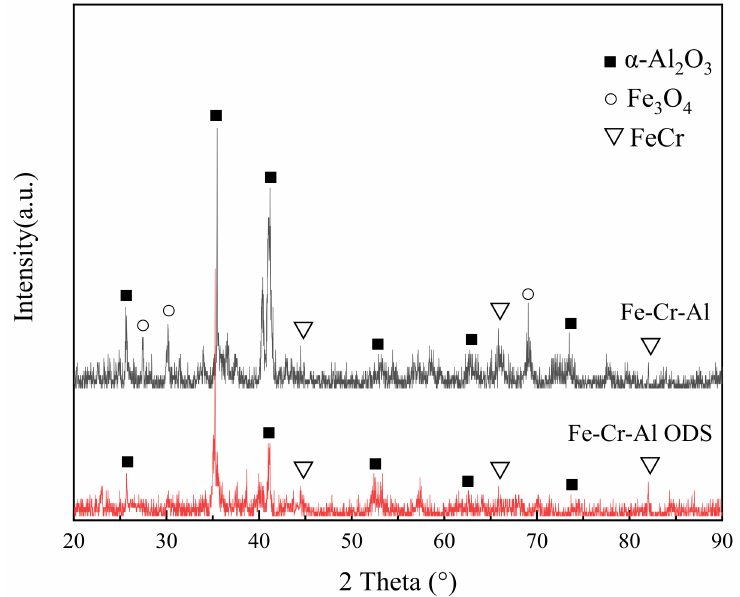
Figure 3. Surface XRD pattern of two alloys after high-temperature